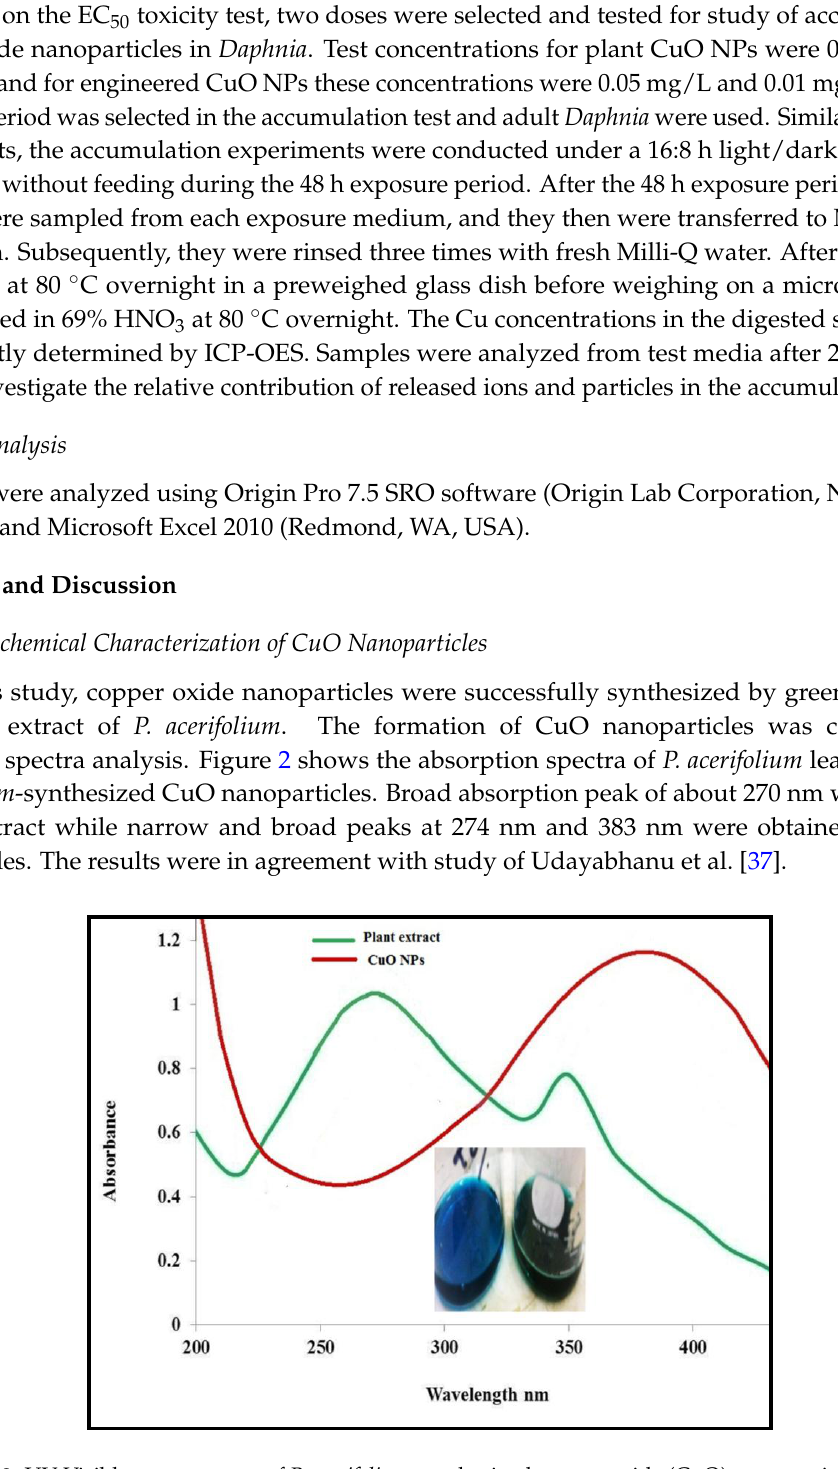
Figure 2. UV-Visible spectroscopy of P. acerifolium -synthesized copper oxide (CuO) nanoparticles